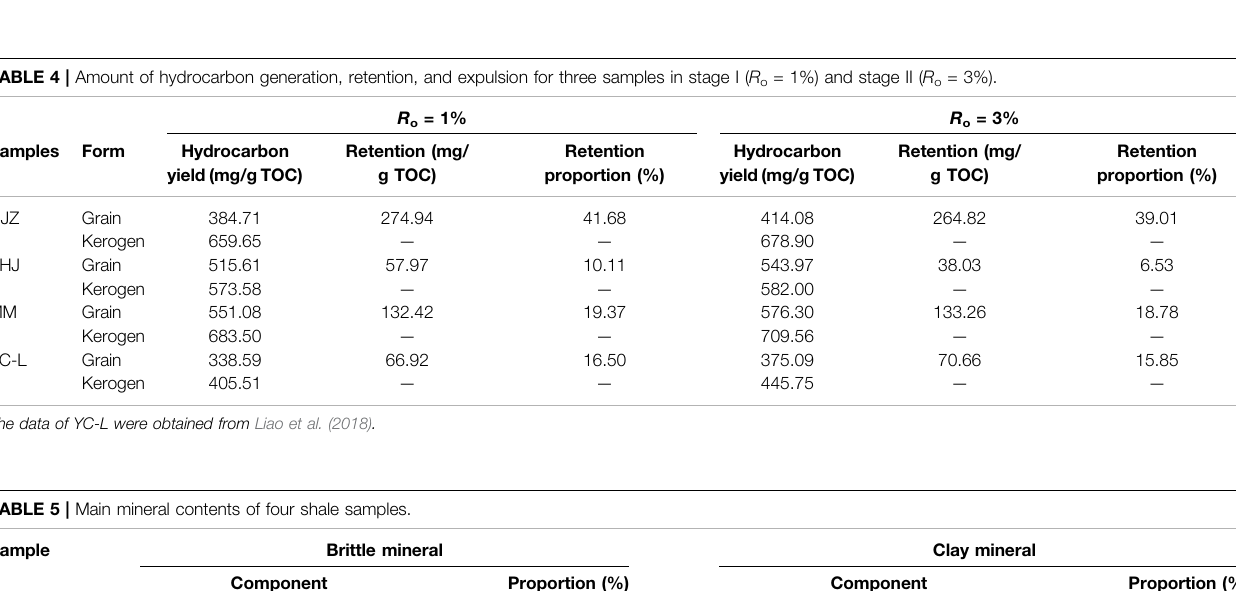
TABLE 4 | Amount of hydrocarbon generation, retention, and expulsion for three samples in stage I ( R o = 1%) and stage II ( R o = 3%).